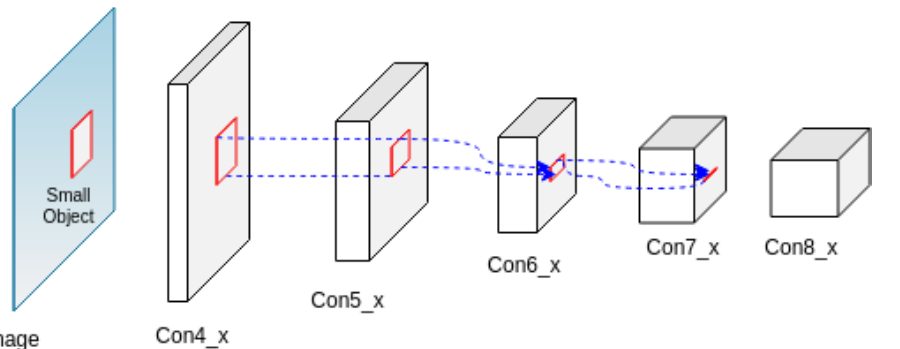
Figure 2. Poor feature representation of small objects at deeper layers of typical Convolutional Neural Networks, which are usually caused by multiple pooling and stride >1 processes.